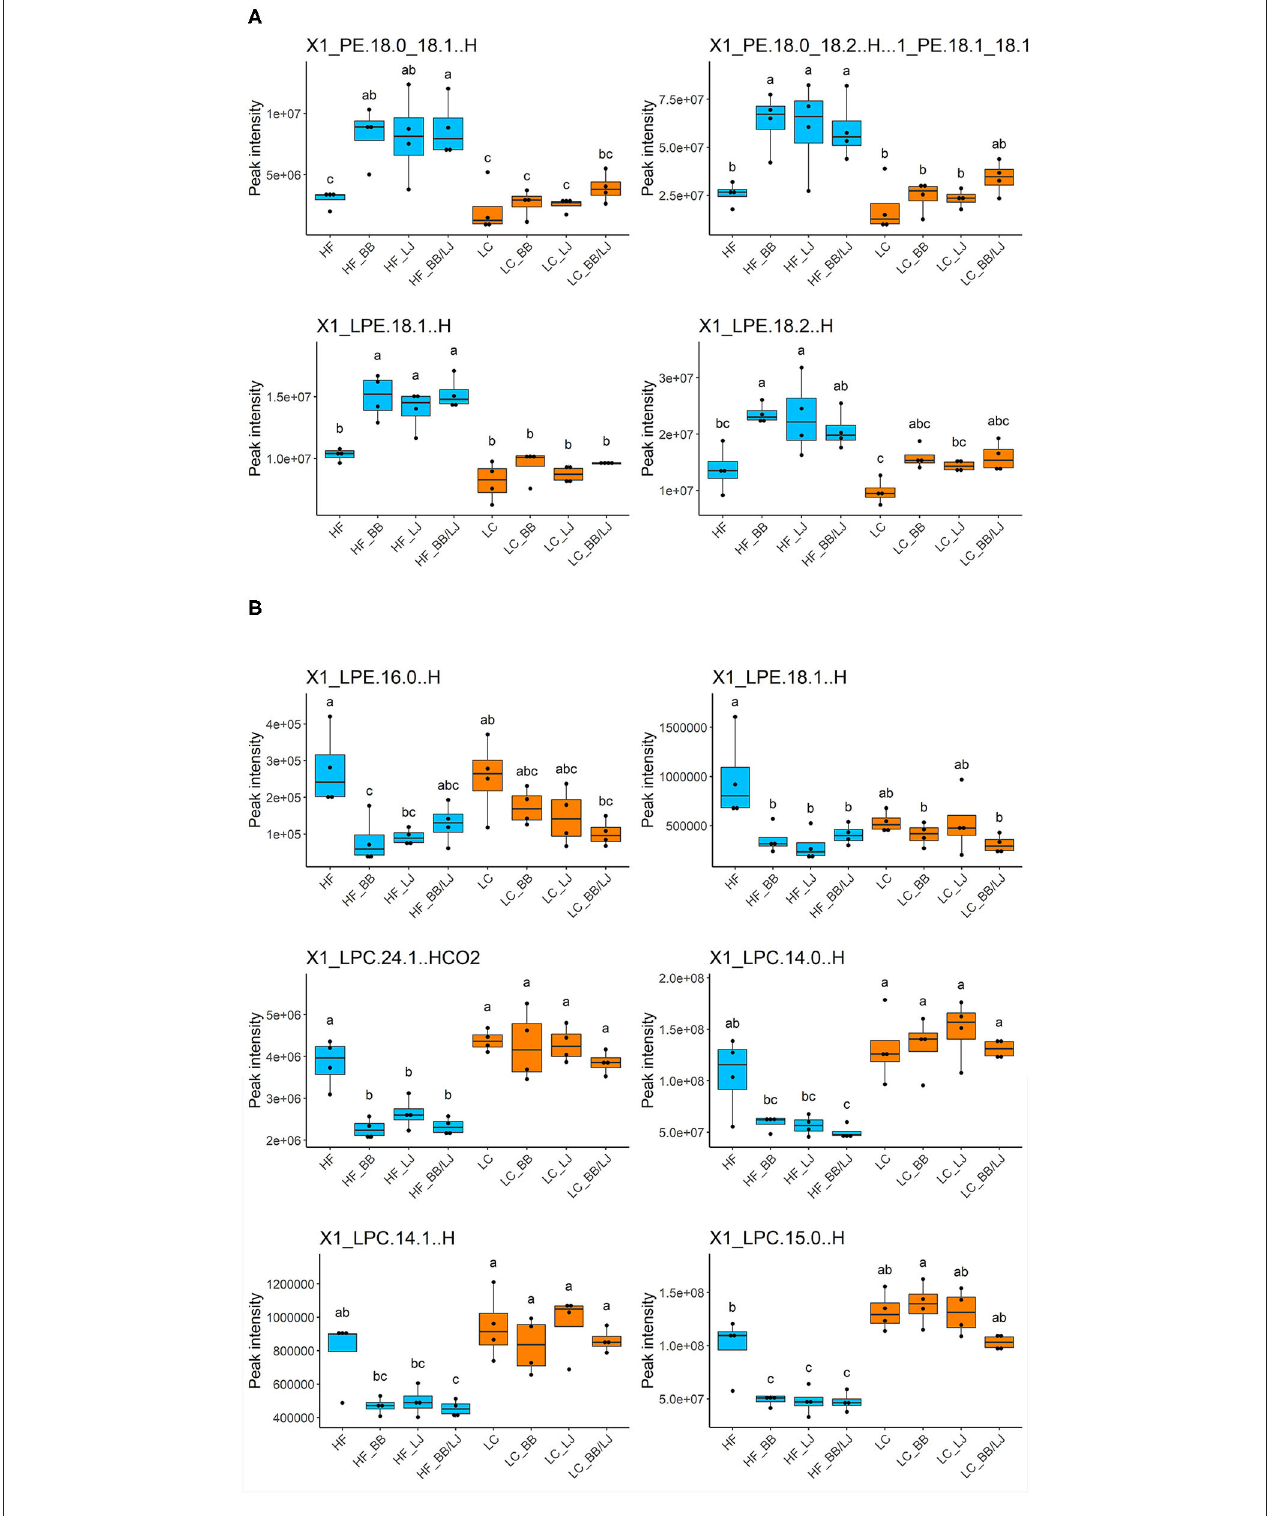
FIGURE 6 | Relative concentration of phospholipids in the analyzed samples. All samples were compared based on the peak intensity of each compound identified. of (A) PE and LPE on serum samples and (B) LPE and LPC on adipose tissue. HF, high-fat diet control group; LC, low-calorie diet control group; BB, blueberry extract; LJ, L. johnsonii N6.2; BB/LJ, blueberry extract + L. johnsonii N6.2. Blue bars: animals under HF diet; orange bars: animals under LC diet. Data is shown as median with max/min. Different letters on top of each box plot indicate significant differences in group means from repeated-measures ANOVA.